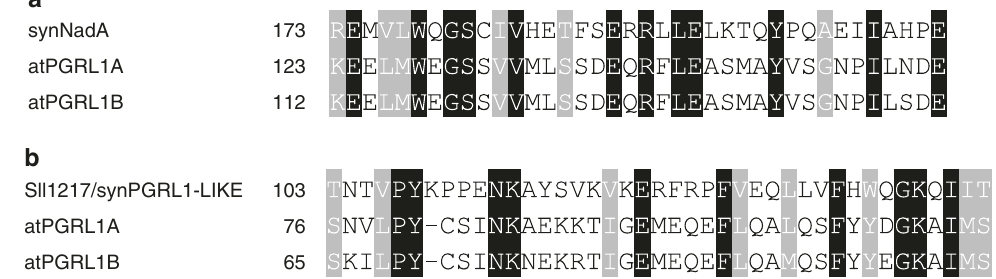
Fig. 2 Short stretches of the cyanobacterial proteins synNadA and Sll1217/synPGRL1-LIKE share sequence similarity with PGRL1. Original CyanoBase 42 pBlast hits (see Supplementary Fig. 3) for synNadA and Sll1217/synPGRL1-LIKE were obtained when only the N-terminal segment (between the cTP and the fi rst TM region) of atPGRL1A was used as the query. Here, alignments of the PGRL1-like sequence stretch of synNadA ( a ) and Sll1217/synPGRL1-LIKE ( b ) with the corresponding stretches in atPGRL1A and atPGRL1B, reconstructed using MUSCLE 43 , are